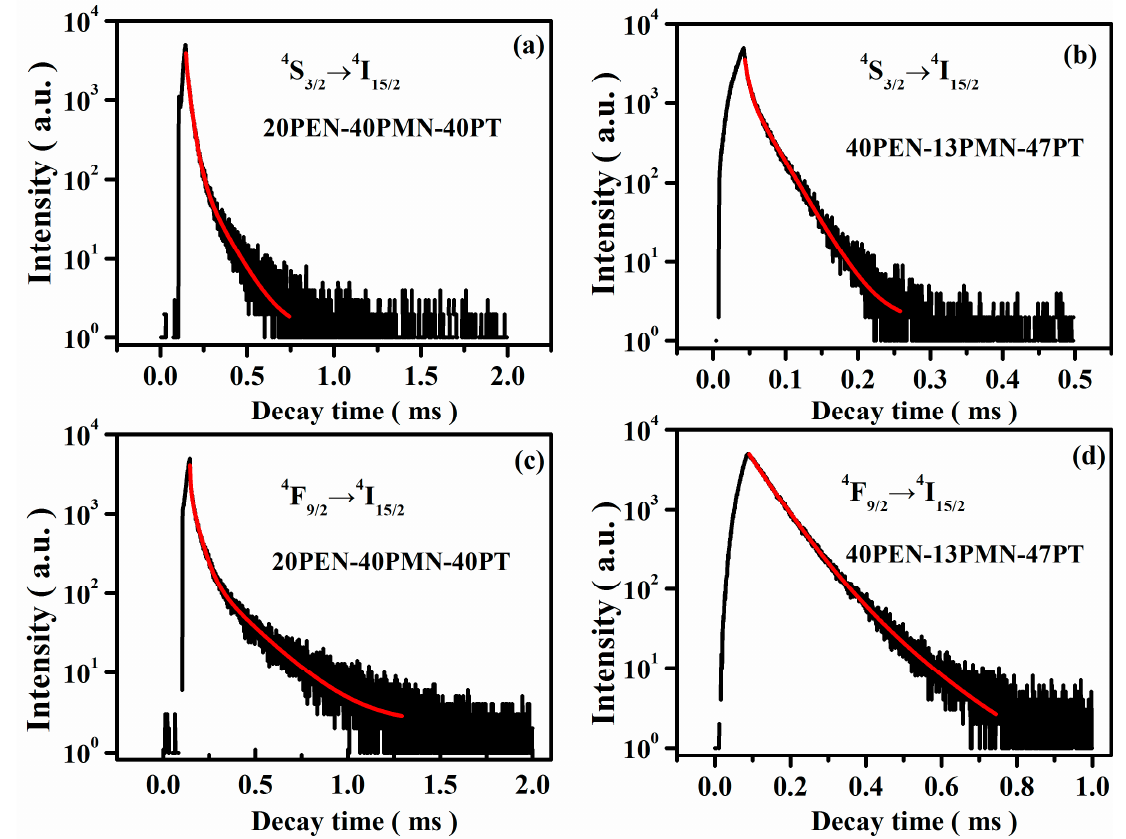
Figure 9. Emission lifetime of PEN-PMN-PT crystals under 980 nm excitation ( a ) 20PEN-40PMN-40PT crystals at 526 nm ( 4 S 3/2 → 4 I 15/2 ); ( b ) 40PEN-13PMN-47PT crystals at 526 nm ( 4 S 3/2 → 4 I 15/2 ); ( c ) 20PEN-40PMN-40PT at 667 nm ( 4 F 9/2 → 4 I 15/2 ); ( d ) 40PEN-13PMN-47PT at 667 nm ( 4 F 9/2 → 4 I 15/2 ).